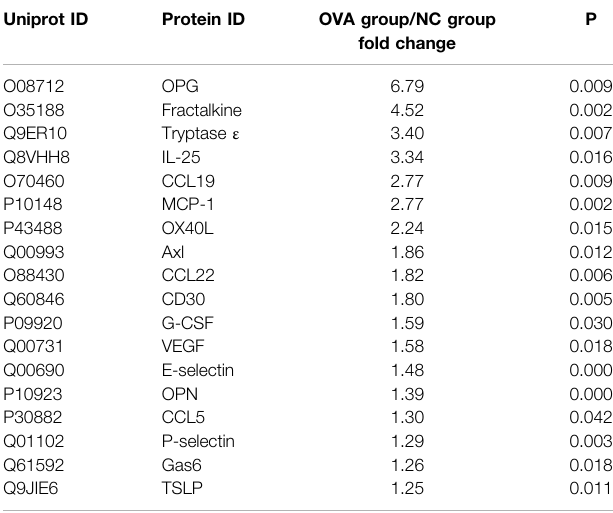
TABLE2| Relativeexpressionchangesofdifferentialexpressed proteinsinserum of OVA-challenged mice ( n (cid:2) 4 – 5). Uniprot ID